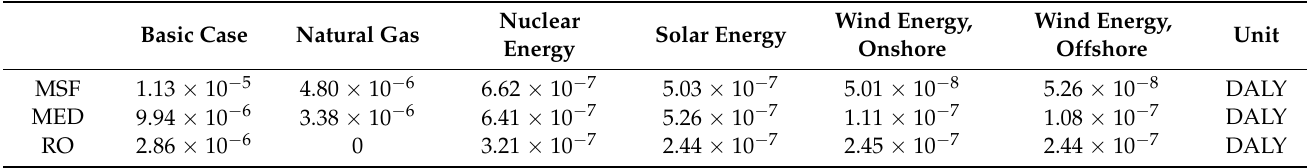
Table 9. Summary of impact assessment results for the human health category for the three technologies used with different energy sources based on the IMPACT 2002+